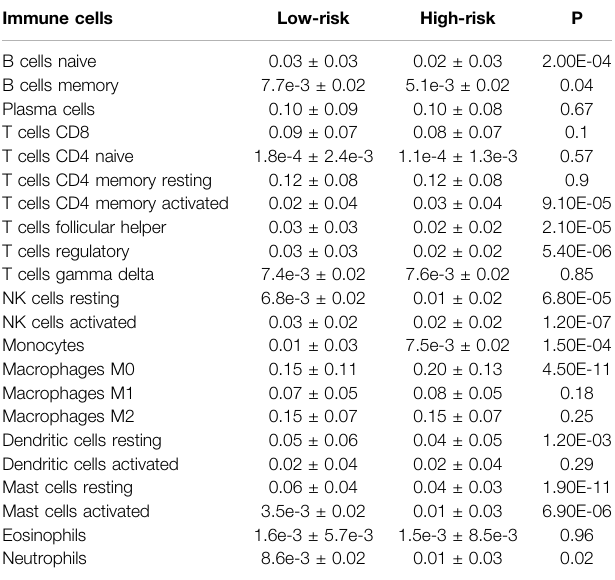
TABLE 4 | The expression levels of NSCLC immune cells in the high- and low-risk groups. Immune cells